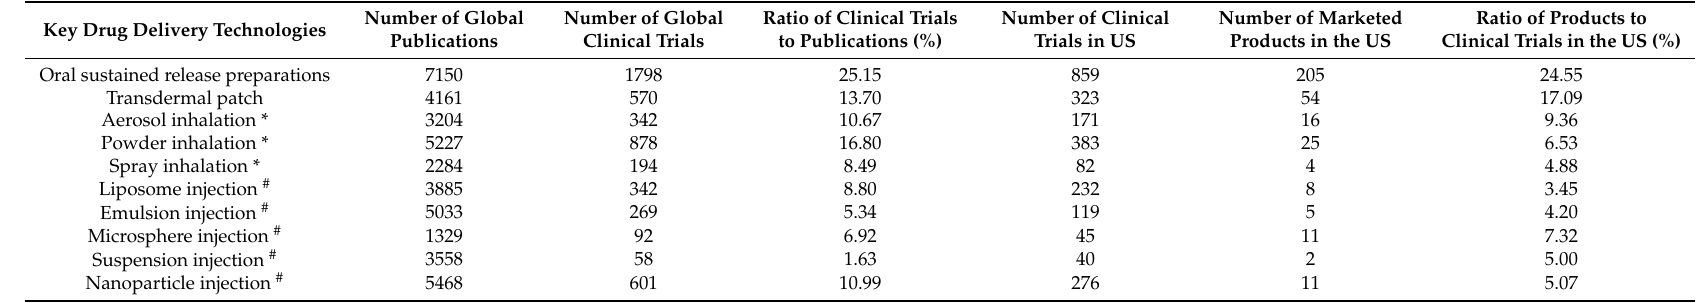
Table 3. Numbers of publications, clinical trials and marketed products of 10 advanced pharmaceutical technologies (1980–2017). Key Drug Delivery